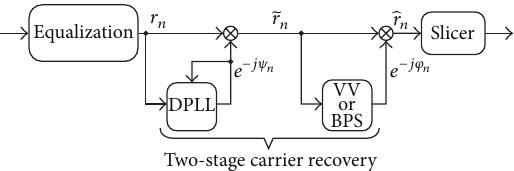
Figure 7: Simplified block diagram of thetwo-stage carrier recovery